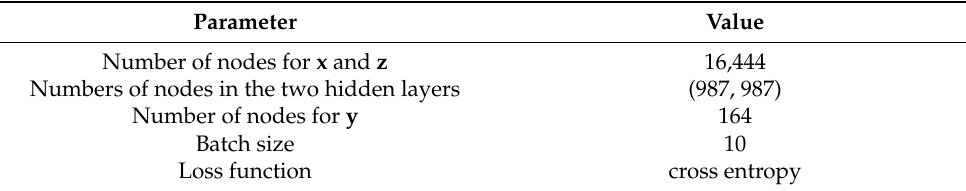
Table 1. The structure and parameter settings for the DAE. Parameter Value Number of nodes for x and z 16,444 Numbers of nodes in the two hidden layers (987, 987) Number of nodes for y 164 Batch size 10 Loss function cross